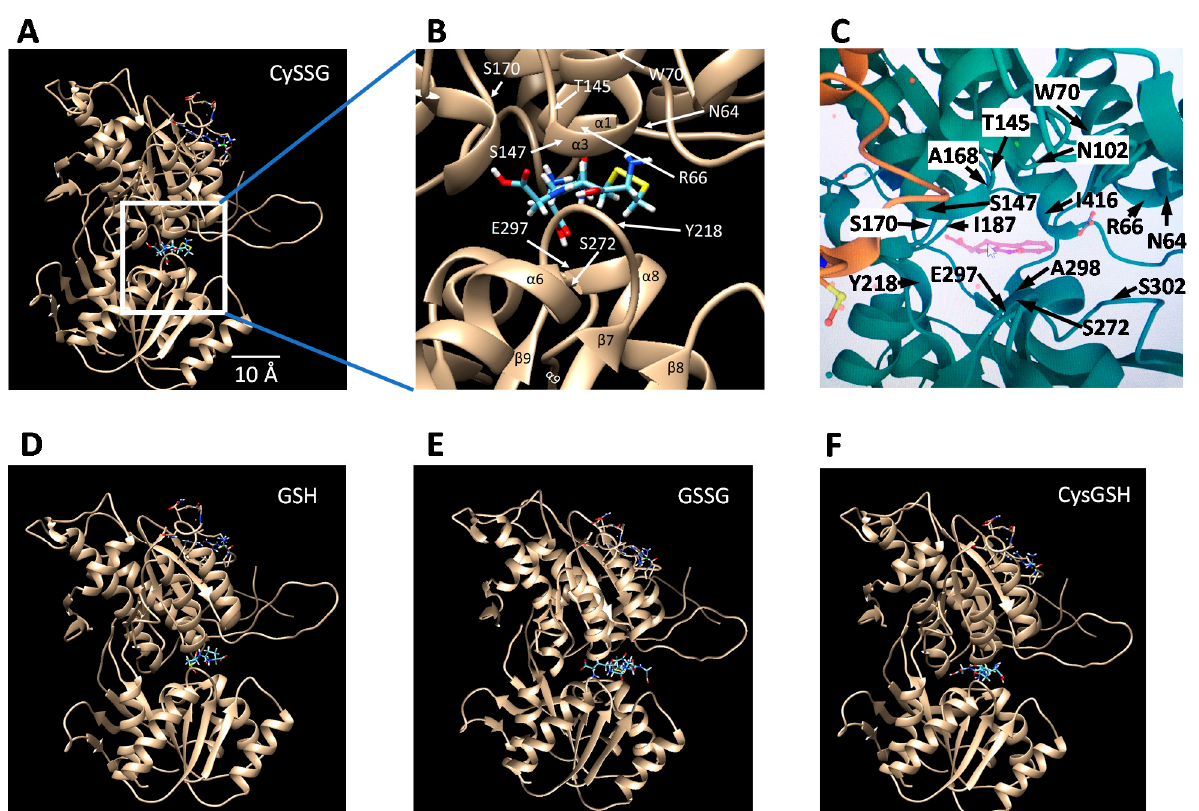
Figure 4. Potential docking sites of glutathionergics to the ECD of CaSR determined with the SwissDock docking simulator [56], and visualized via UCSF Chimera [57] visualization software. Images show Chain B of the CaSR ECD structure with ligands ( A ) and ( B ) CySSG, ( D ) GSH, ( E ) GSSG, and ( F ) CysGSH, docked in the binding site corresponding to where tryptophan and ( C ) a tryptophan derivative [5] are known to bind. Docking simulations utilized the pdb ID 5FBK 3d structure of the CaSR ECD. CySSG and CysGSH were obtained from PubChem CID 44119801 and CID 3080690, respectively, converted from 3d .XML files to .Mol2 files using Open Babel, version 2.3.1, http://openbabel.org (accessed 28 August 2021), ref. [58]; GSH was obtained from Zinc ID 3830891 as a .Mol2 file; GSSG was obtained from zinc ID 3870129 as a .Mol2 file. Pdb ID 5FBK was modified to contain only Chain B of the receptor. The docking region of interest in Chain B was restricted to SwissDock’s XYZ center—35, 17, and 27 with XYZ sizes of 15. ( B ) zooms into the binding site of ( A ) to identify the locations of CaSR residues adjacent to CySSG, for comparison to ( C ) the comparable region identified and labeled as in Zhang et al. [5] and rendered here from the RCSB PDB (http://rcsb.org, accessed on 28 August 2021, ref. [59]) of PDB ID of 5FBH [5] (same as 5FBK but with methylcyclotryptophan included (pink molecule in the center). The yellow side chain of an amino acid in the lower left of (C) is part of C482 of the A chain. Identification of alpha helices and beta sheet regions and the numbering and location of the residues in ( B ) is derived from data given by Zhang et al. [5], Figure 1 and Figure S1. The length calibration in ( A ) is based on the turn-to-turn distance of the illustrated alpha helices (5.4 Å).